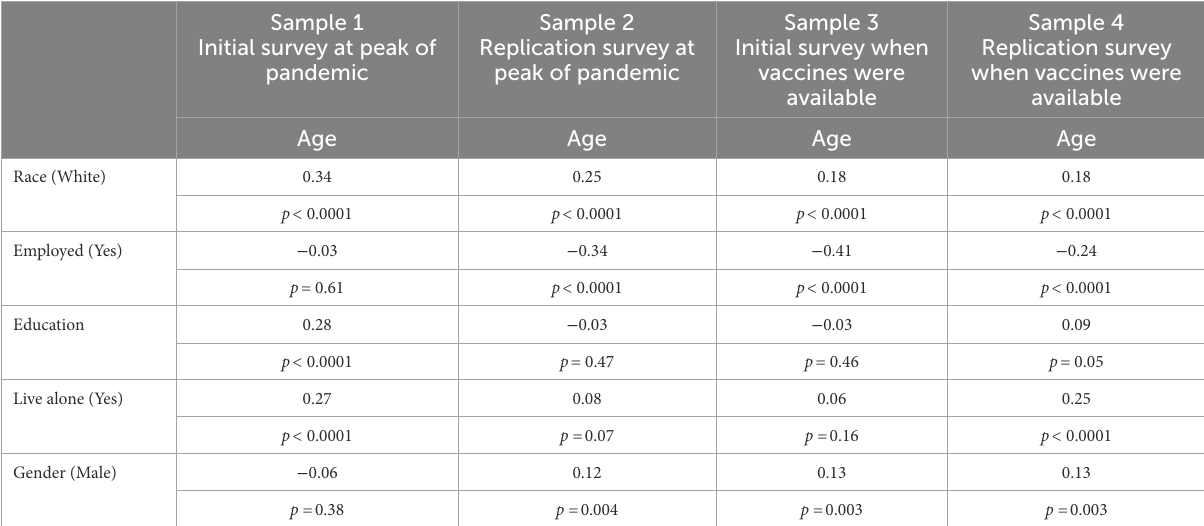
TABLE 2 Pearson’s correlations between age and other variables in four samples.